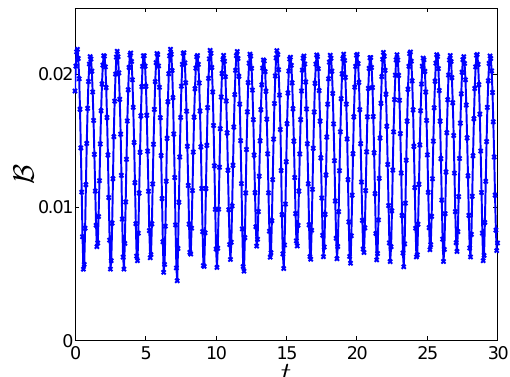
Fig. 2. Temporal evolution of the imbalance B for initially balanced fields of the modified slow-fast Lorenz-96 model (Eqs. 17–18).